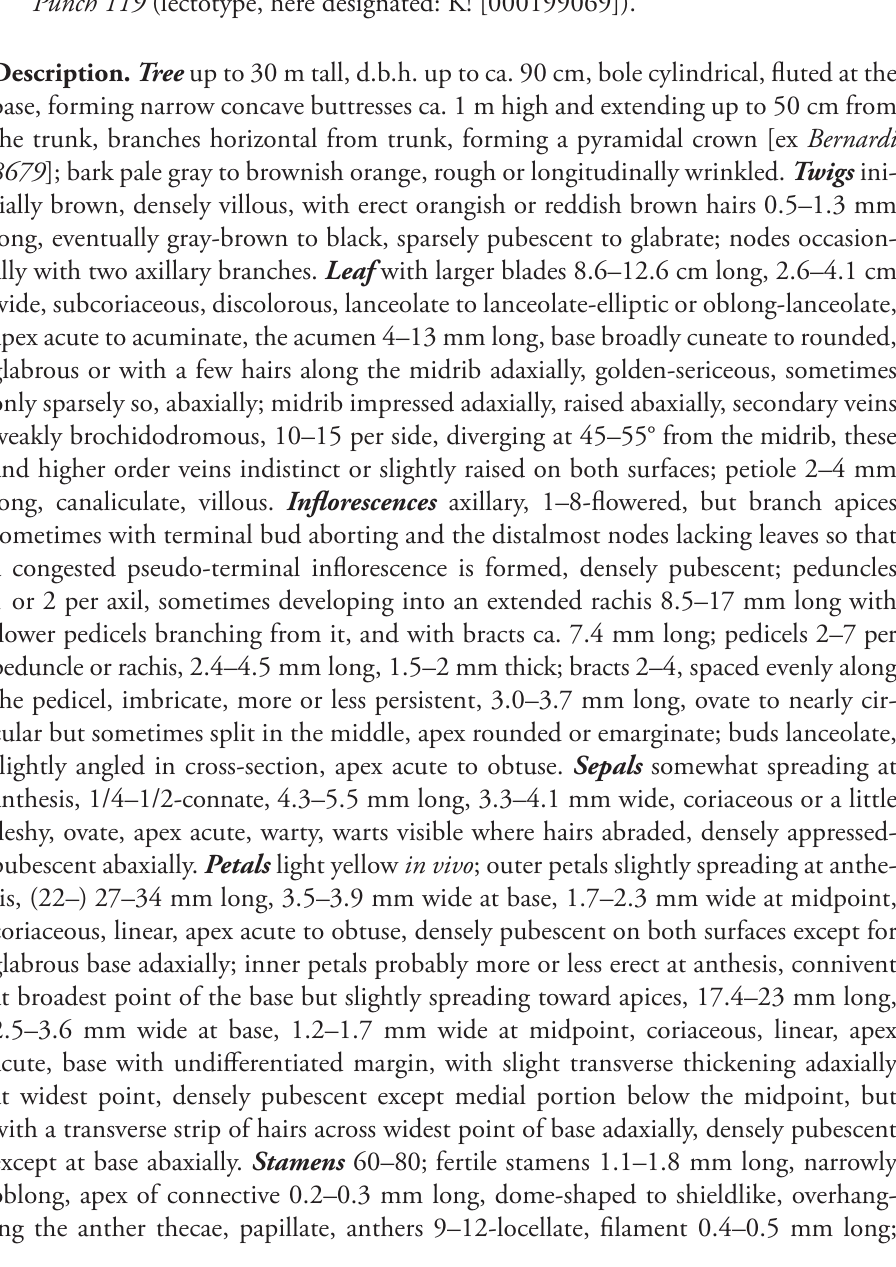
Fig. 48A–G Xylopiastrum villosum (Chipp) Aubréville, Flor. For. Côte d’Ivoire, ed. 2, 1: 140. 1959. Type. NIGERIA. Lagos State, Ibadan Forest Reserve, Lagos, 17 Nov 1900, C. Punch 119 (lectotype, here designated: K!